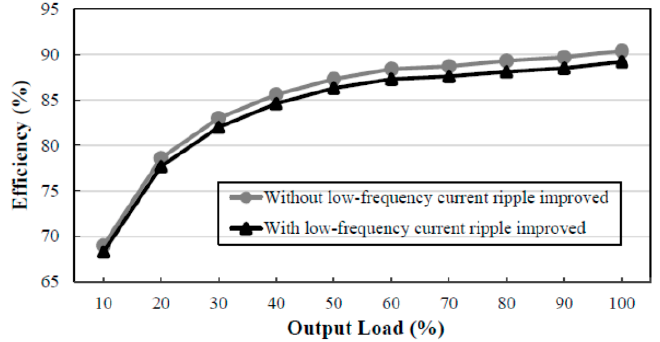
Figure 12. Curve of efficiency versus output load under 220 V input voltage.